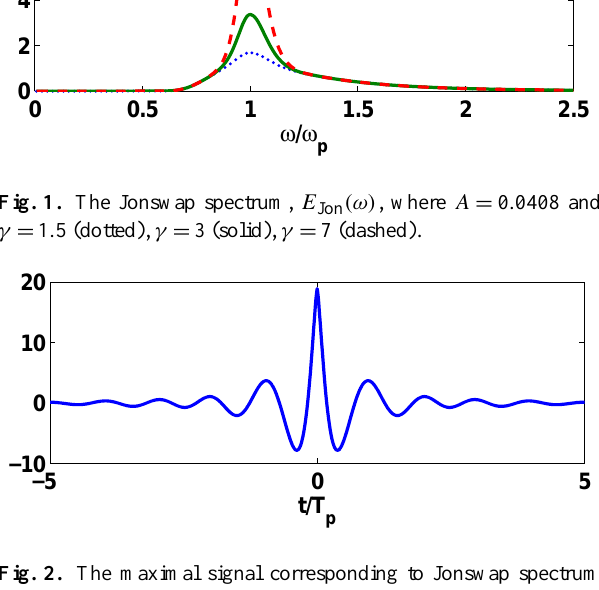
Fig. 2. The maximal signal corresponding to Jonswap spectrum with γ =